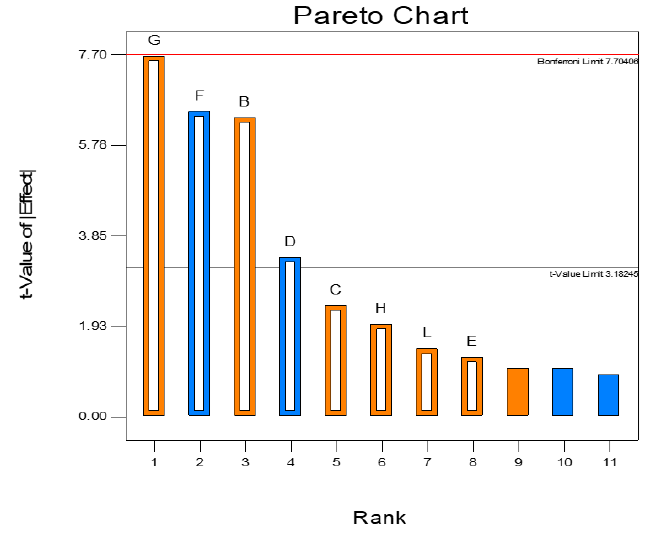
Figure 2. Pareto chart of Plackett–Burman design (P–BD) results showing the effects of individual factors on enzyme production, where B = peptone *, C = yeast extract, D = aeration *, E = Tween, F = CaCl 2 *, G = incubation period *, H = temperature, and L = inoculum size.* Refers to significant factors with SD 361.6.4 and R-squared 0.9603.